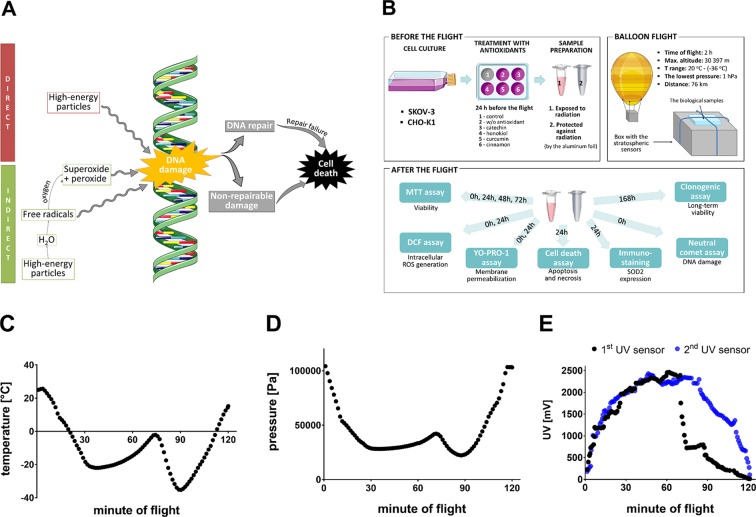
(A) Effect of the radiation on the DNA. High-energy particles could affect DNA damage either by direct pathway or indirect pathway. Free radicals and by-products of the process of water radiolysis contribute to an increase in the oxidative stress in the cell affecting the DNA. Survival of the cell depends on the extent of the DNA damage (Anand et al., 1997; Cohen-Jonathan et al., 1999; Desouky et al., 2015). (B) The schematic representation of the procedure of experiment and balloon flight. (C) The temperature fluctuations (°C) during the balloon flight outside the payload; the sensor was located at the top wall of gondola. (D) The pressure fluctuations (Pa) during the balloon flight; the sensor was located at the top wall of gondola. (E) UV radiation fluctuations (mV) during the balloon flight. The first UV sensor was located at the top wall of the gondola, the second UV sensor measured UV radiation at the side wall. This figure was prepared using Servier Medical Art, available from www.servier.com/Powerpoint-image-bank.